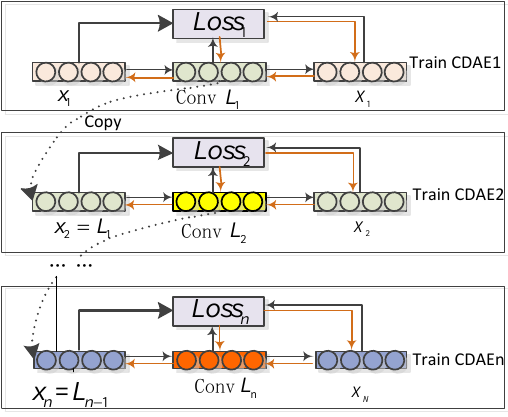
Figure 2. SCDAE model training process.